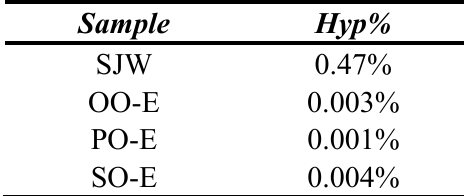
Table 1. Total hypericins content in SJW oil